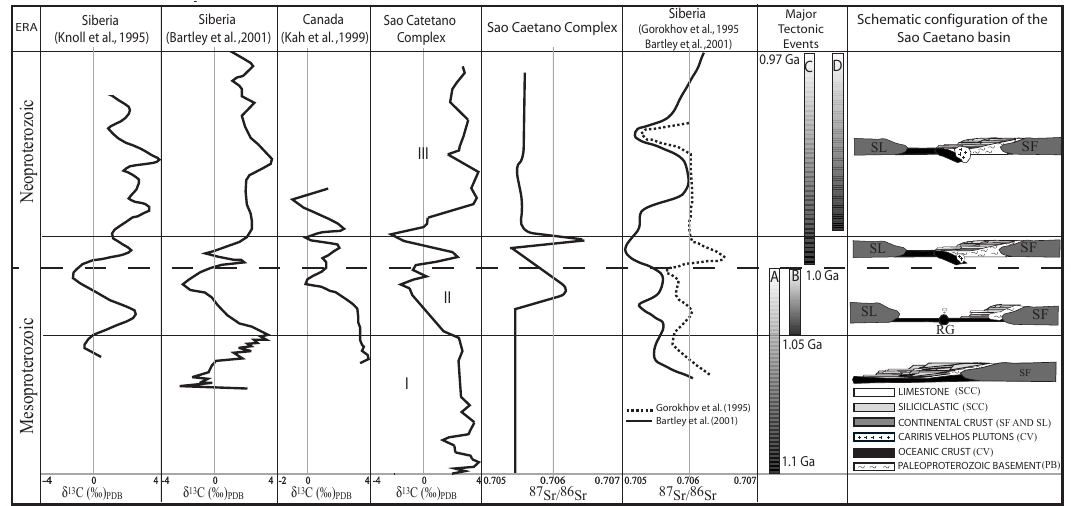
Fig. 7 – Chemostratigraphic C- and Sr- trends from different carbonate sequences worldwide representing the original composition of the Meso-Neoproterozoic seawater. Note the similarity between the chemostratigraphic pathways from SCC marbles and those from unmetamorphosed sequences in Siberia and Canada. Roman numbers represent C-isotope stages 1, 2 and 3. Strong perturbations in C- and Sr- chemostratigraphic record seem to coincide with major tectonic events. (A) Offset of the Greenville orogeny, (B) Late Mesoproterozoic Rifting, (C) Cariris Velhos Orogeny, (D) Rodinia agglutination. A schematic configuration of the SCC basin is also shown. (SF) São Francisco Craton, (SL) São Luis Craton, (RG) Riacho-Gravata Complex.